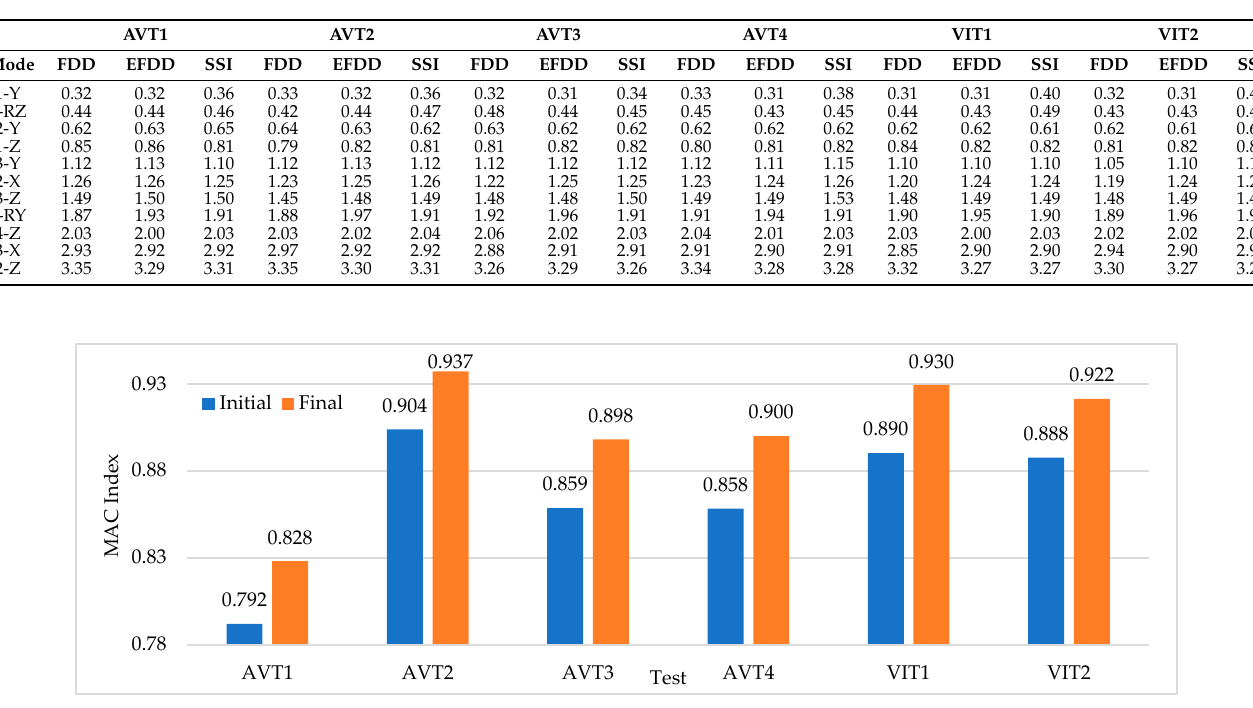
Table 3. Experimental frequencies obtained from dynamic tests.